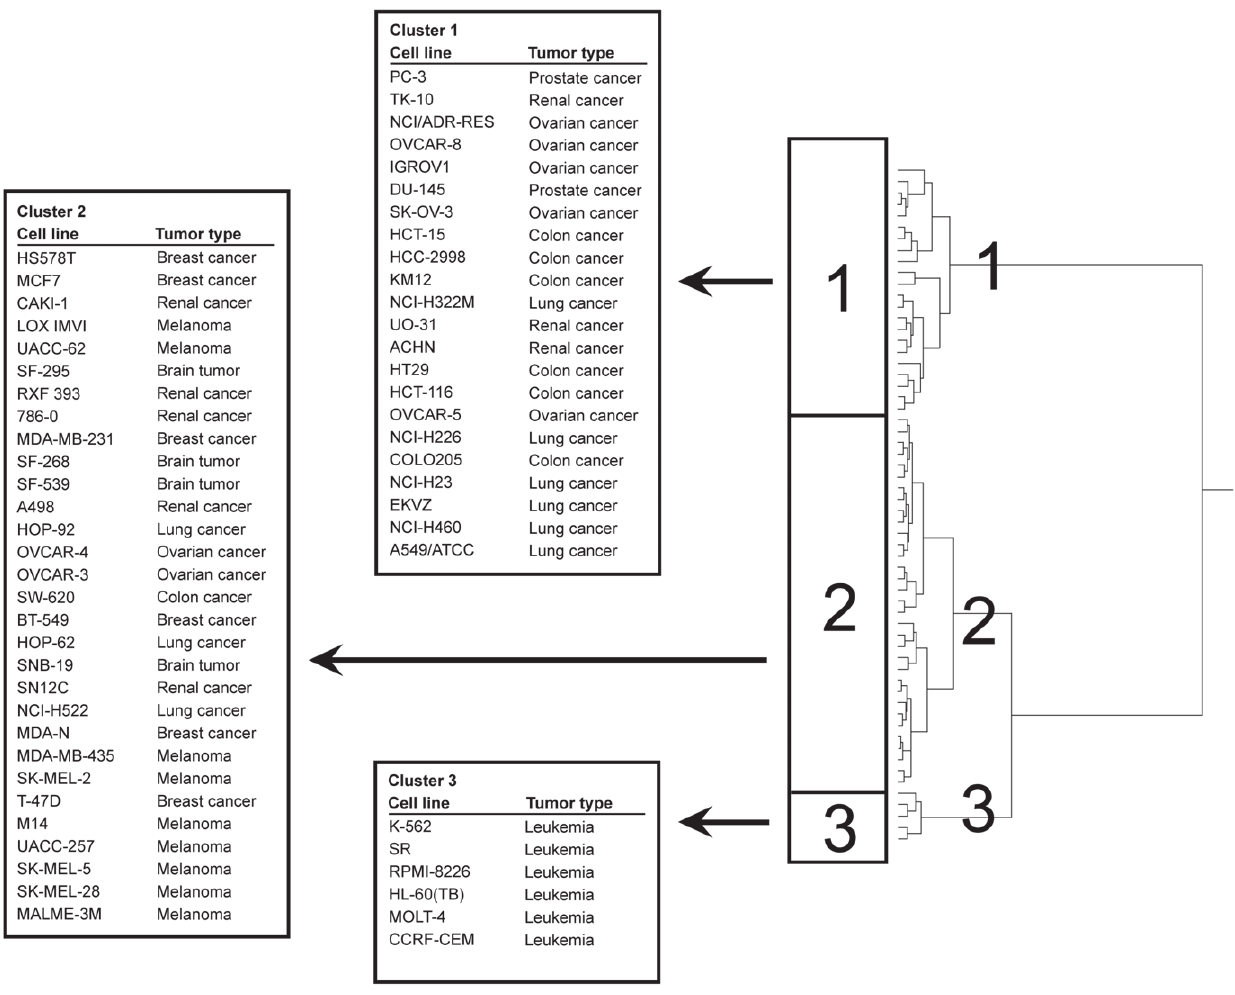
Figure 3. Hierarchical cluster analysis of microarray-based mRNA gene expression obtained by standard and reverse COMPARE analyses. The dendrogram shows the clustering of the NCI-60 cell line panel and indicates the degrees of relatedness between cell lines.